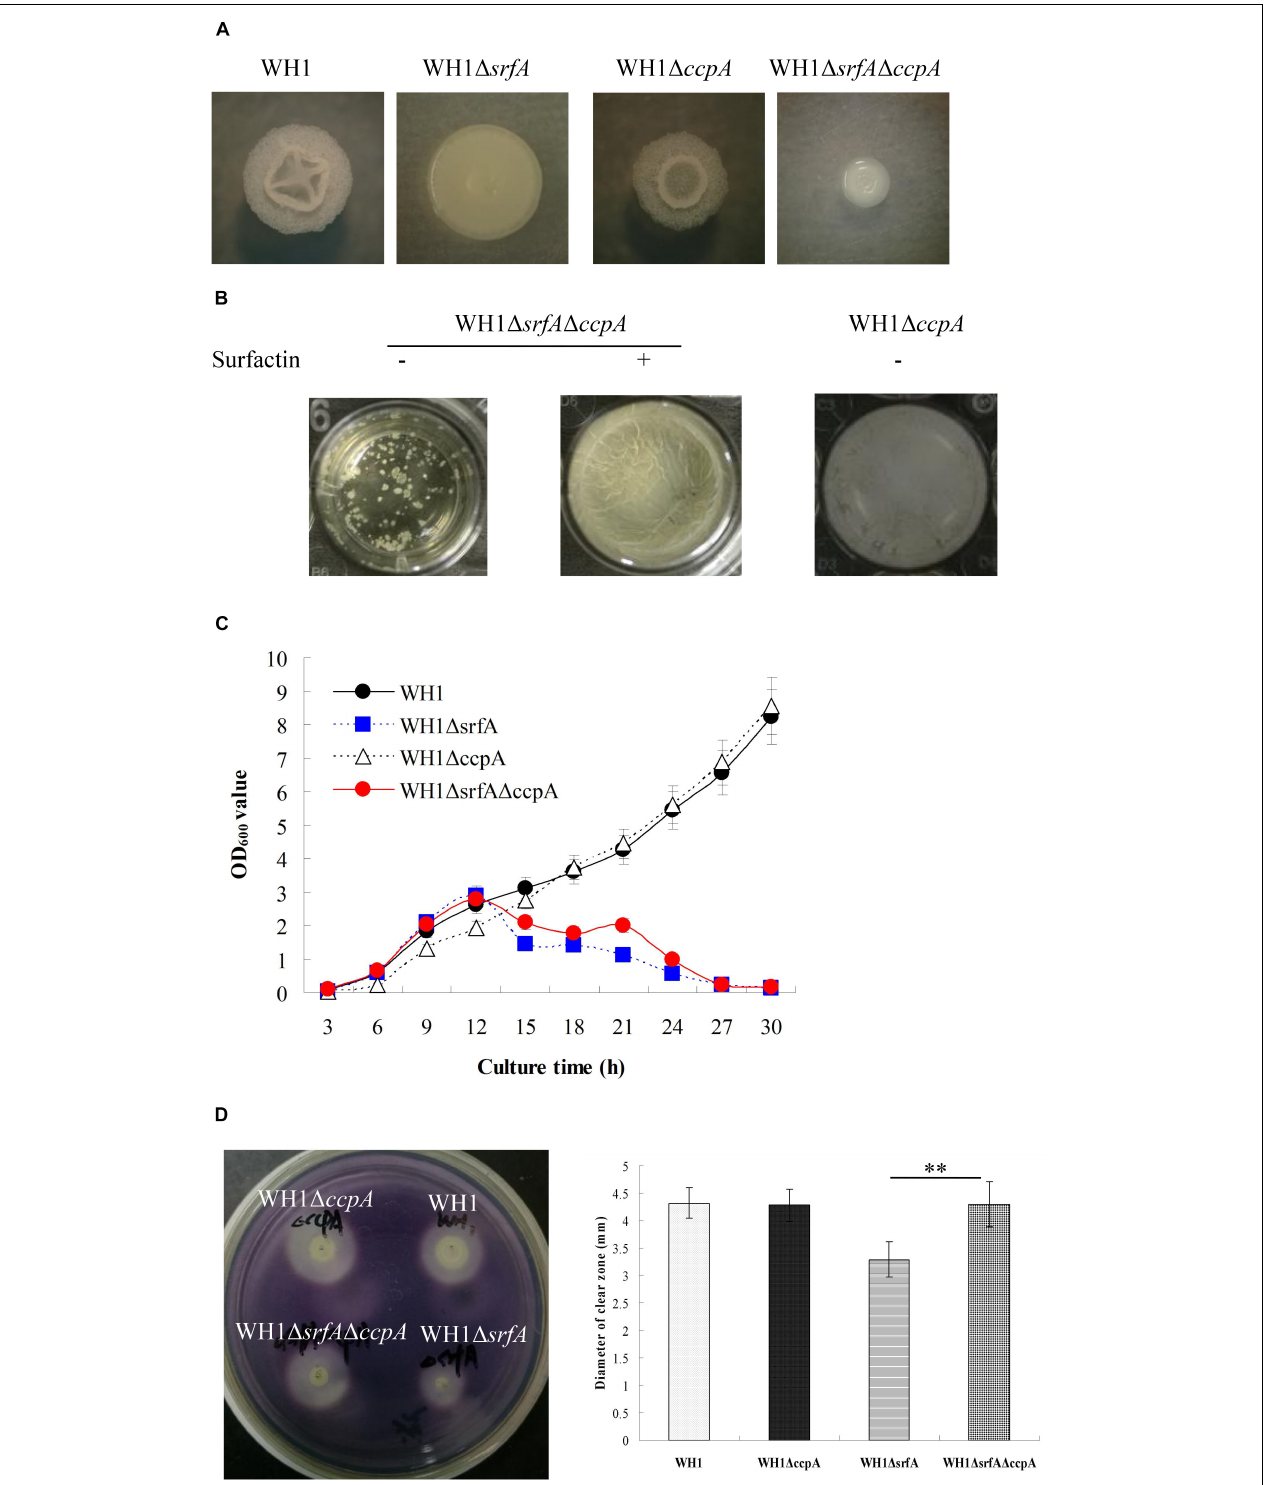
FIGURE 7 | Mutation of srfA had obviously an effect on CcpA-dependent CCR. (A) Colony morphology of ccpA -null mutant strains. (B) Addition with surfactin restored the biofilm formation in (cid:49) srfA (cid:49) ccpA . (C) Growth curves of ccpA -null mutant strains in LB medium. Knockout of ccpA could partially restore the growth of (cid:49) srfA in LB medium. (D) The α -amylase activity of wild type and mutants on LB agar plates supplemented with starch. The α -amylase activity was weakened in (cid:49) srfA compared to WH1, but could be restored by further knockout of ccpA in (cid:49) srfA . Double stars indicate significant difference ( p < 0.01) between two groups.